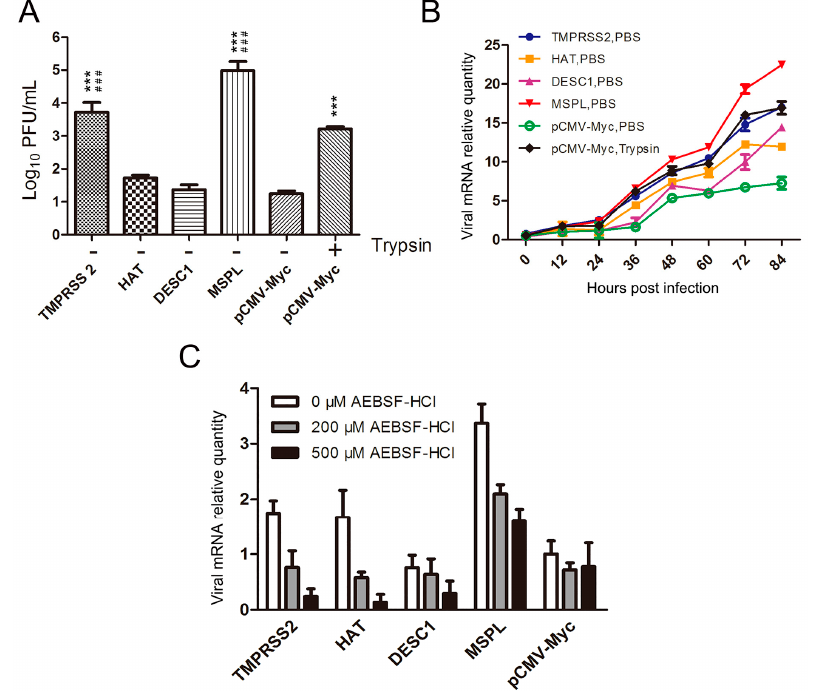
Figure 2. Effects of TTSPs and TTSP inhibitor on viral replication. ( A ) Porcine epidemic diarrhea virus (PEDV) titers following the expression of TTSPs in Vero cells. Viral titers were determined by